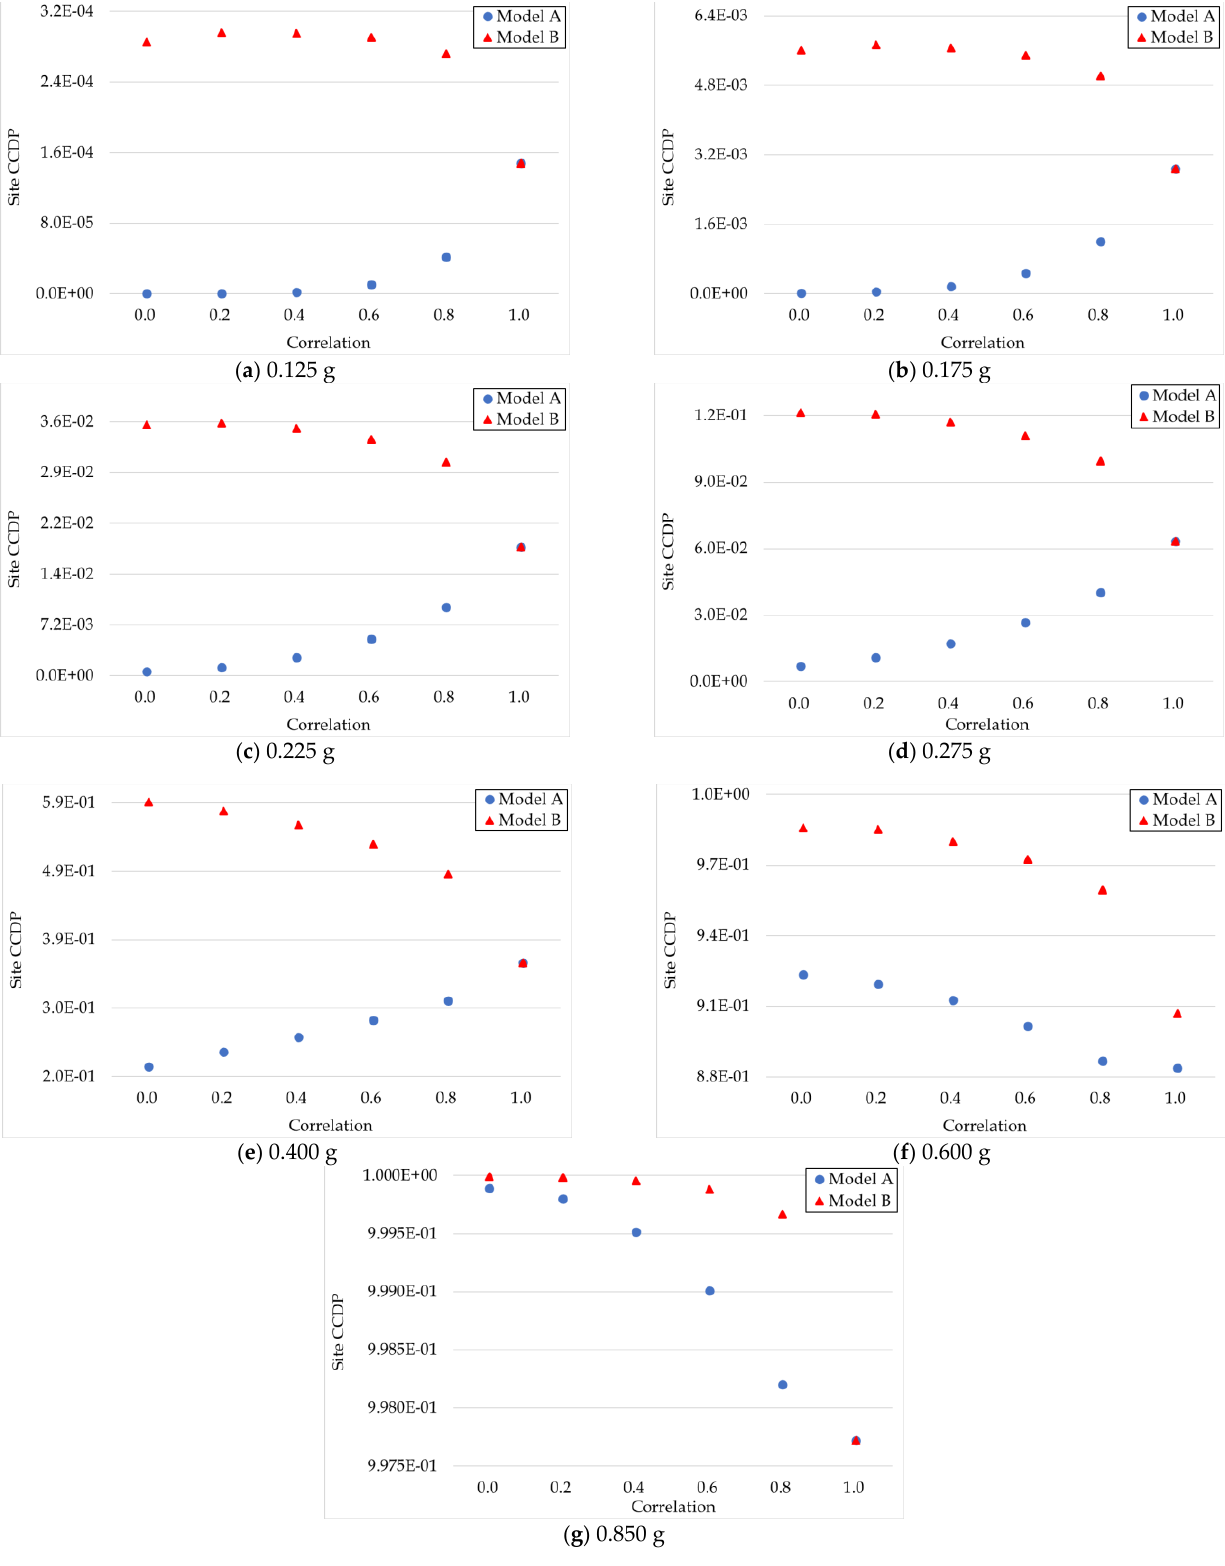
Figure 17. Plots of SCCDP versus seismic correlation.